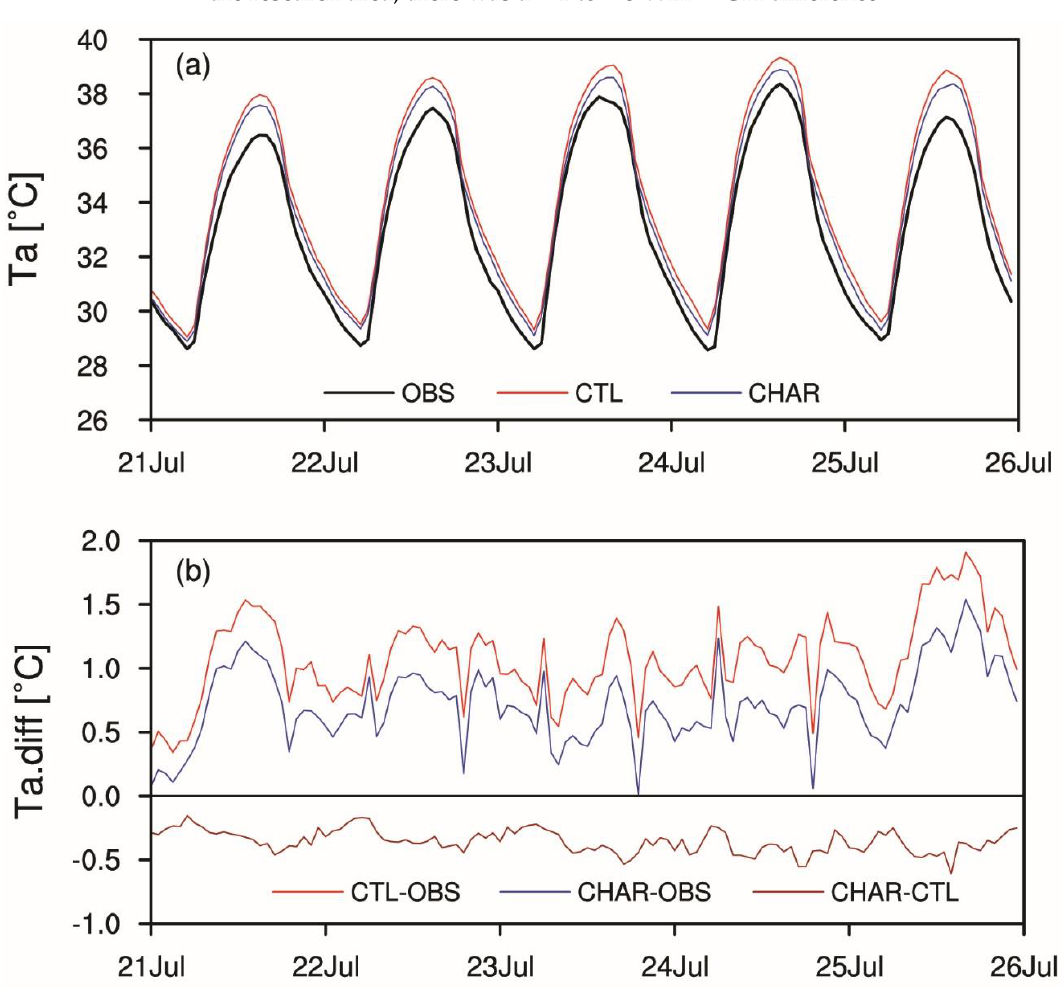
9 of 17 Figure 6. Spatial distribution of mean air temperature (unit: °C) for ( a ) CTL experiment, ( b ) CHAR experiment, and ( c ) their difference over the research period in EC. Figure 7a presents the hourly variations of area-averaged observed and simulated Ta